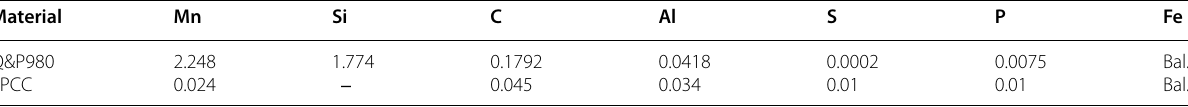
Table 1 Chemical composition of Q&P980 and SPCC steel (mass fraction, %) Material Mn Si